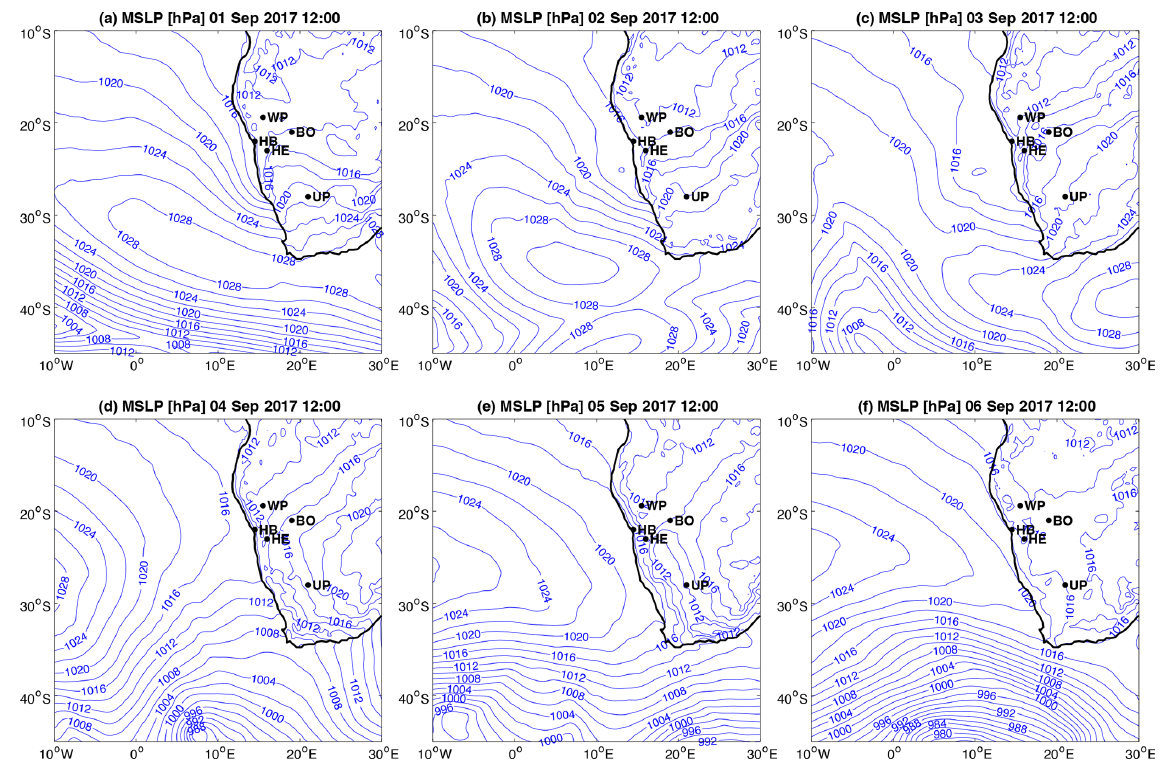
Figure 2. Mean sea level pressure (hPa) at 12:00UTC on (a) 1 September, (b) 2 September, (c) 3 September, (d) 4 September, (e) 5 September and (f) 6 September 2017 from ERA5 reanalysis. The names of the instrumented sites appear in black (from north to south): WP is Windpoort, BO is Bonanza, HB is Henties Bay, HE is HESS (Namibia) and UP is Upington (South